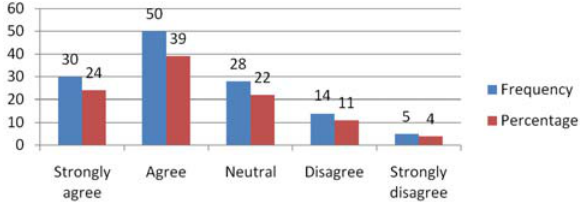
Fig. 8. Impact of high collateral requirements impact business